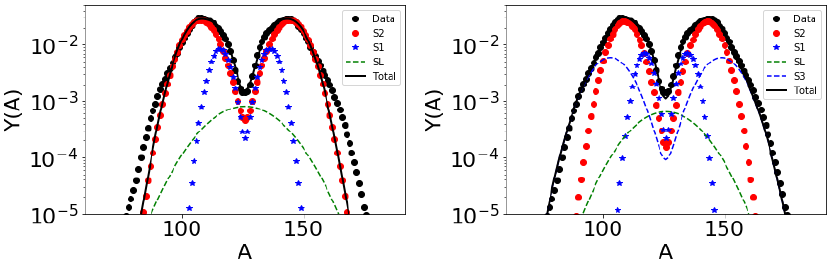
Figure 1. Mass yields when (left) three Brosa modes were fit using the MCMC and when (right) four Brosa modes were fit. Black solid lines show the total fit compared to the experimental data from